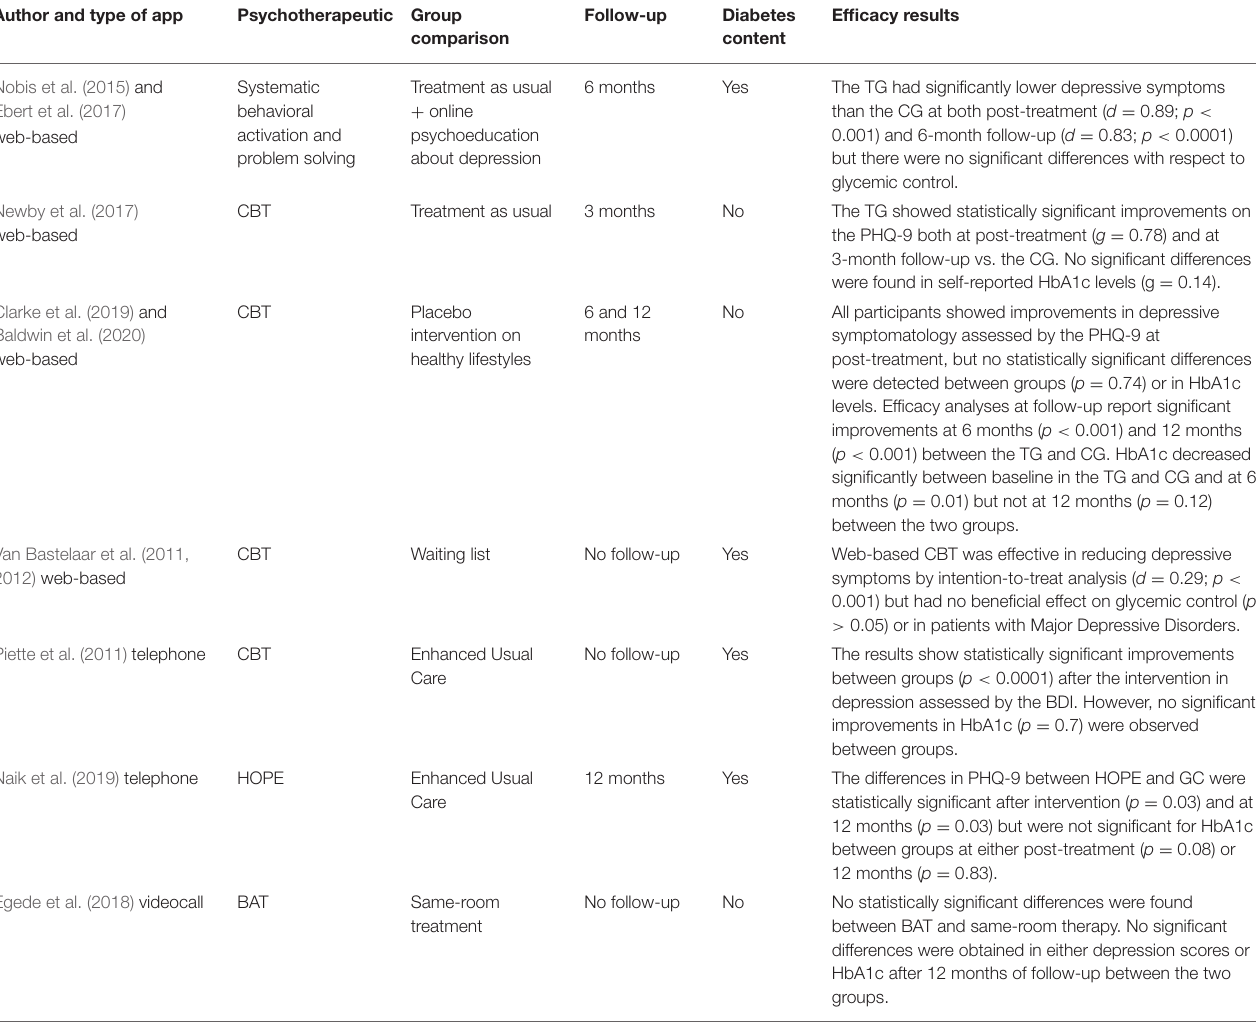
TABLE 2 | Characteristics of the intervention and efficacy results in depression and